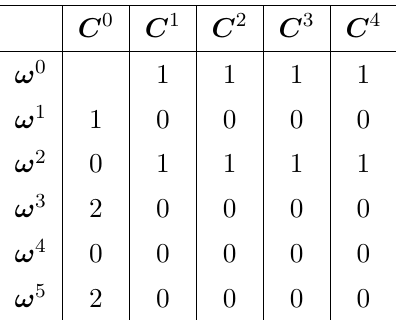
Table 2 . On-shell closed/gauge-invariant currents in the A 1 toy model. The table shows the number of independent currents that are of ω m C n -type, i.e., involve m one-forms ω and n zero-forms C . that are obviously gauge invariant and d -closed on-shell. For an appropriately chosen wave- function C it can give correlation functions of O = χ 2 , where χ is a generalized free scalar field on the 2 d CFT boundary of AdS . The significance of this is unclear since the dual 3 CFT is expected to have a much bigger W -symmetry. 34 These invariants are unobstructed. Class ω 2 k +1 , Chern-Simons